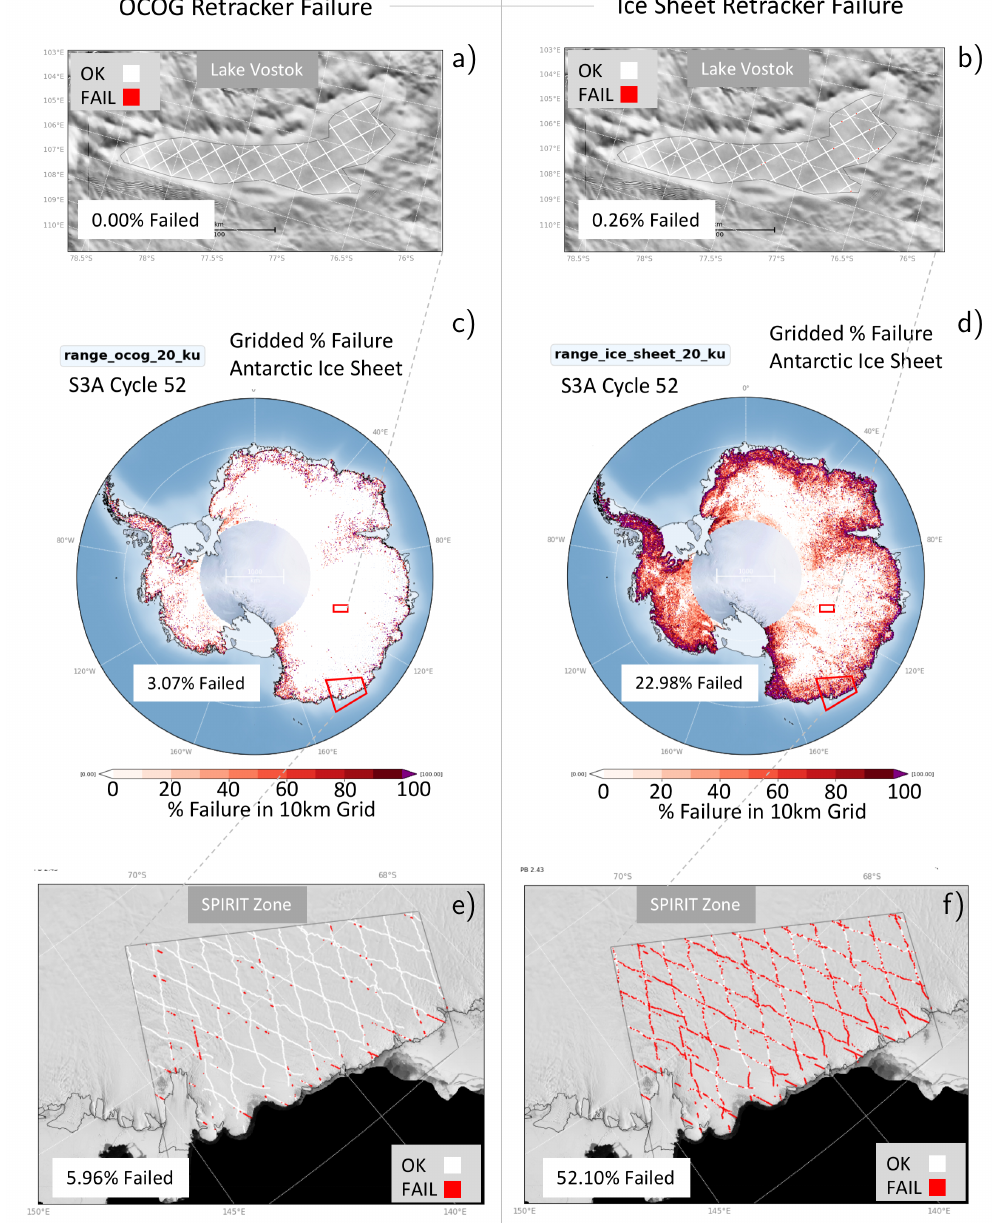
Figure 30. Monitoring retracker failure for S3A Cycle 52 (PB2.43) over 3 different areas. ( a , b ) along-track failure over Lake Vostok area of low slope, ( c , d ) 10 km gridded percentage failure over the Antarctic ice sheet, ( e , f ) along-track failure over the SPIRIT marginal zone of high